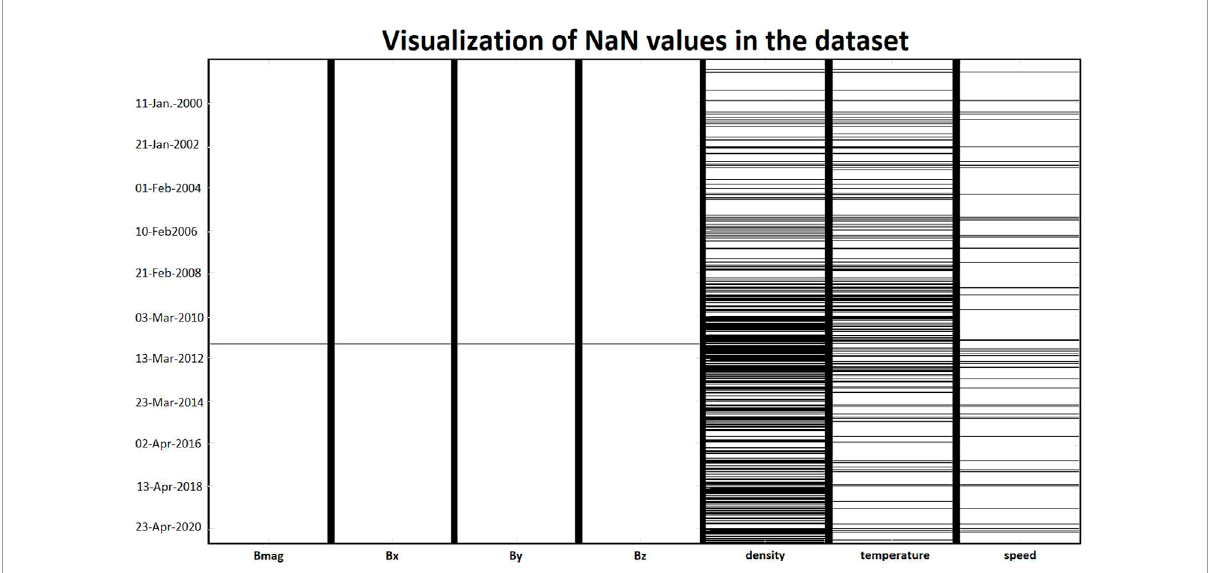
FIGURE 5 Visualization of missing values (i.e., NaN—Not a Number) in the dataset. Each black and white column here represent all values of one variable (see x -axis). Each line of pixels within these columns represent the presence (horizontal white lines) or absence (horizontal black lines) of values for a given datetime ( y -axis). All dataset is shown from first to last datetime, every 64 s. These maps help quickly visualize when in time are the missing values and which parameter is the most affected.